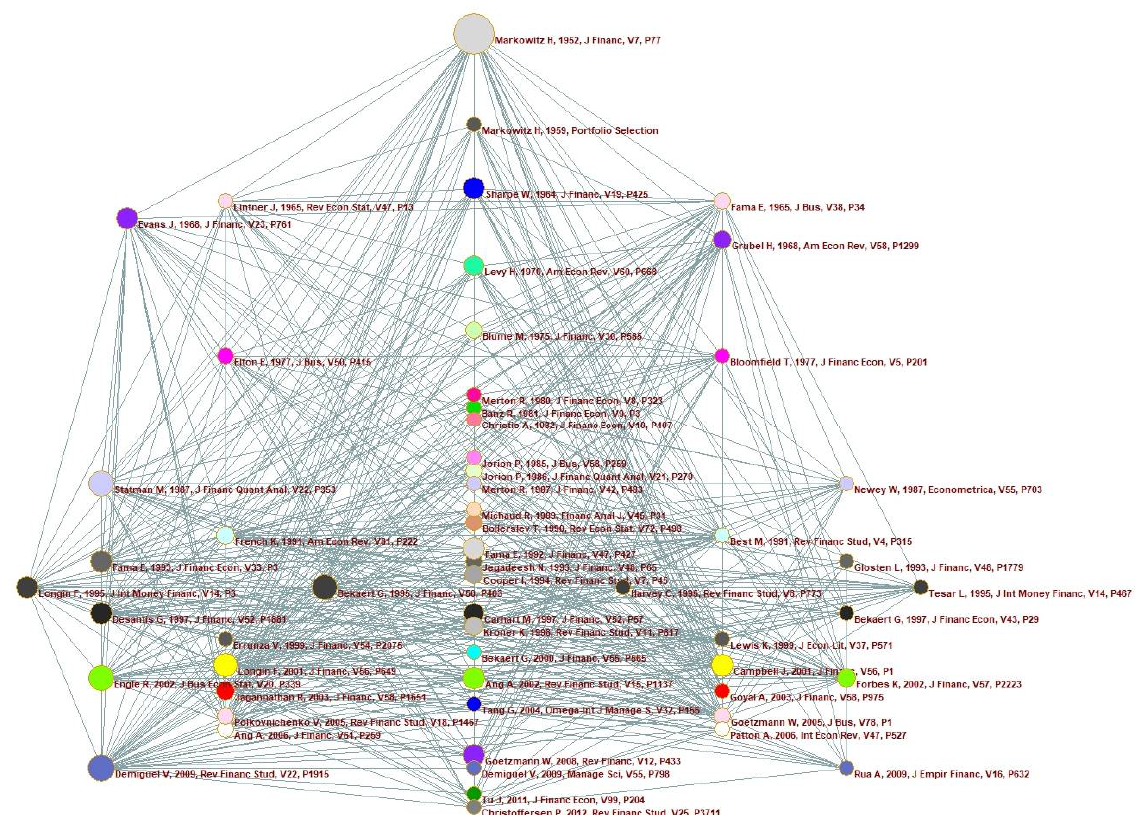
Figure 2. Co-citation analysis—chronological overview.